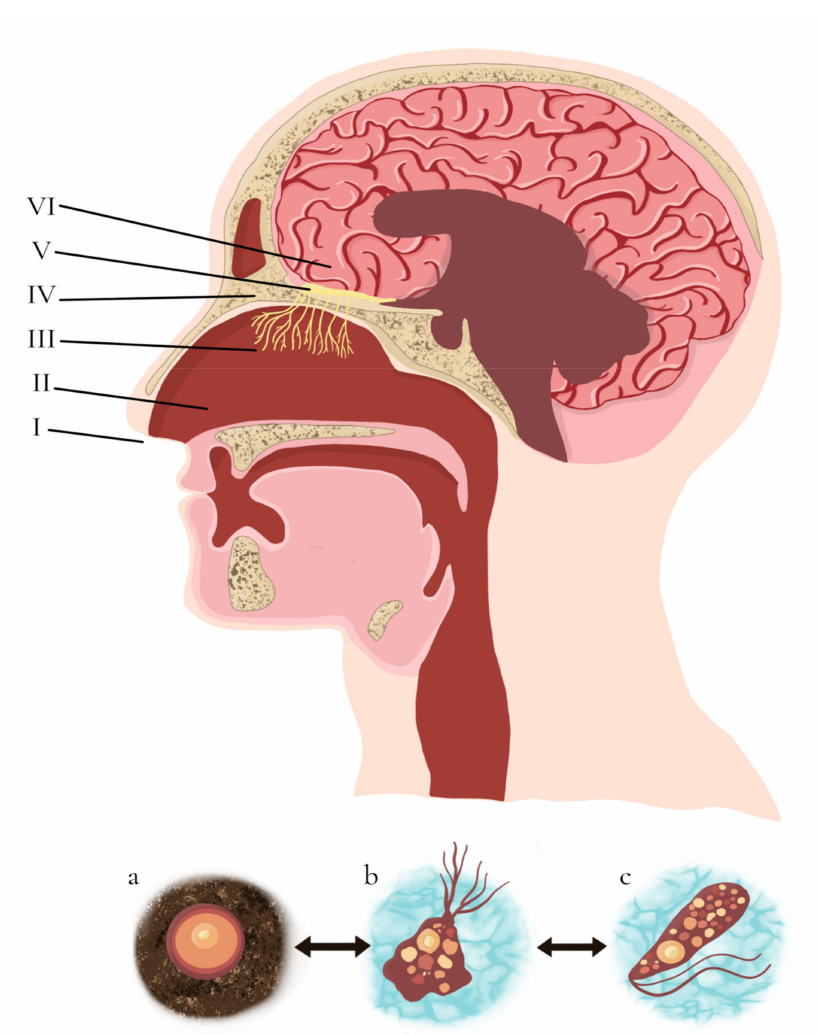
Figure 2. Infection mechanism and forms of N. fowleri, Adapted from [30]. Depending on its surrounding environment, N. fowleri exists in three different forms: A dormant cyst ( a ) capable of surviving different physical and chemical conditions, a reproductively active trophozoite ( b ), that can reproduce, feed, encyst, and cause infection in other organisms and a transitory flagellate ( c ) [10–15]. N. fowleri trophozoites infect their hosts through water entering the nasal cavity (I). Afterwards, the amoeba attaches itself to the nasal mucosa (II) and migrates along the olfactory nerves (III) through the cribriform plate (IV) until it reaches the olfactory bulb (V). Trophozoites then enter the brain (VI) through olfactory nerve bundles, where they multiply and cause severe cerebral damage and inflammation